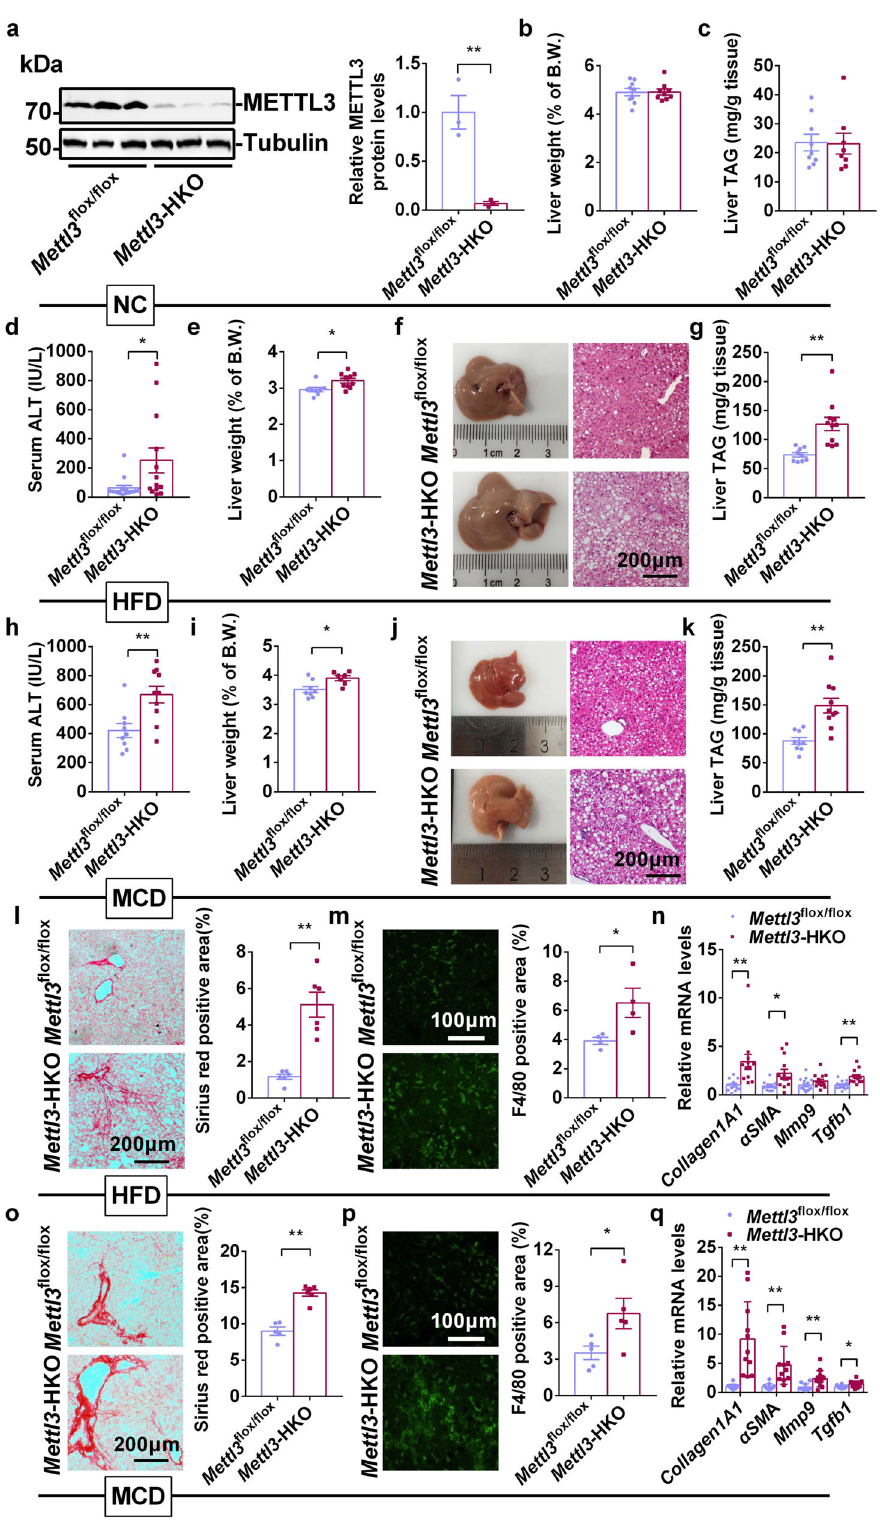
gene expression pro fi les in the livers of Mettl3 -HKO and Mettl3- fl ox/ fl ox mice, we performed RNA-sequencing (RNA-seq) analysis. As shown in Fig. 5a, a total of 551 genes were upregulated, and 474 genes were downregulated. Gene Ontology (GO) analysis showed that genes related to defense response, immune system process, immune response, and innate immune response were